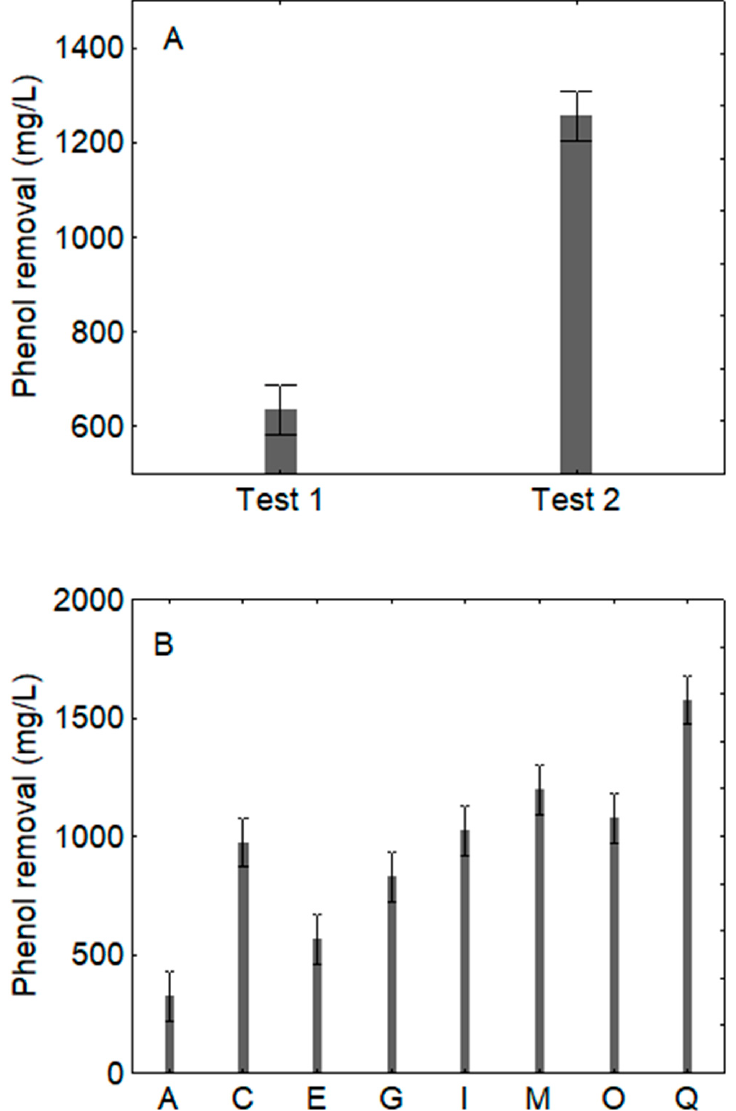
Figure 2. Decomposition of the statistical hypothesis for the effects of inoculation ( A ); p -level, <0.0001) and combinations of the design ( B ); p -level, <0.0001) on the removal of phenols on ATOPW (aged table olive processing water). Mean value ± 95% confidence interval. Test 1: inoculum of C. boidinii followed 3 days after by B. pumilus ; test 2: inoculum of B. pumilus and 3 days after C. boidinii .